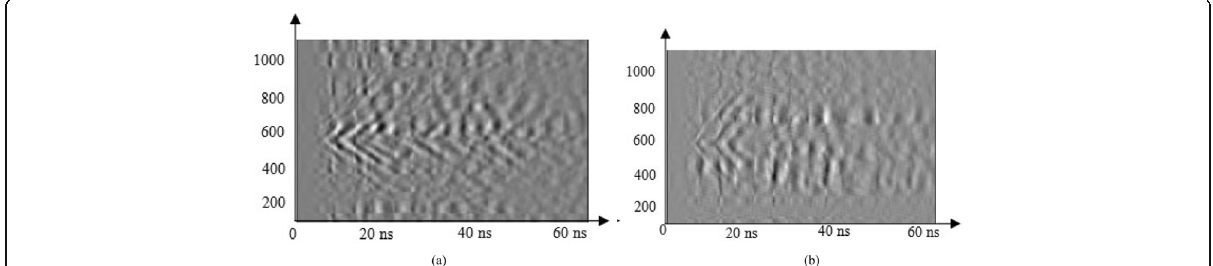
Fig. 13 Imaging results for fixed target moving system. a Imaging results when perpendicular to moving system. b Imaging results when parallel to moving system